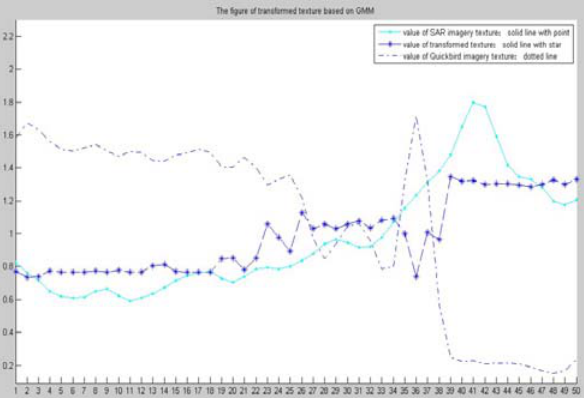
Figure 10. The comparison of